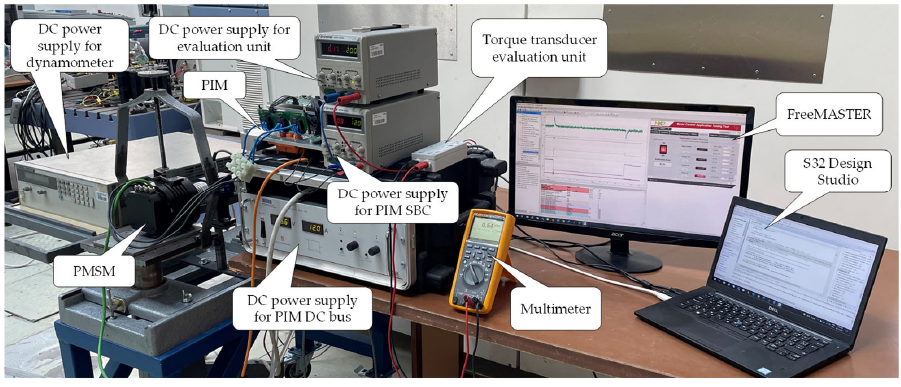
Figure 19. Experimental setup.